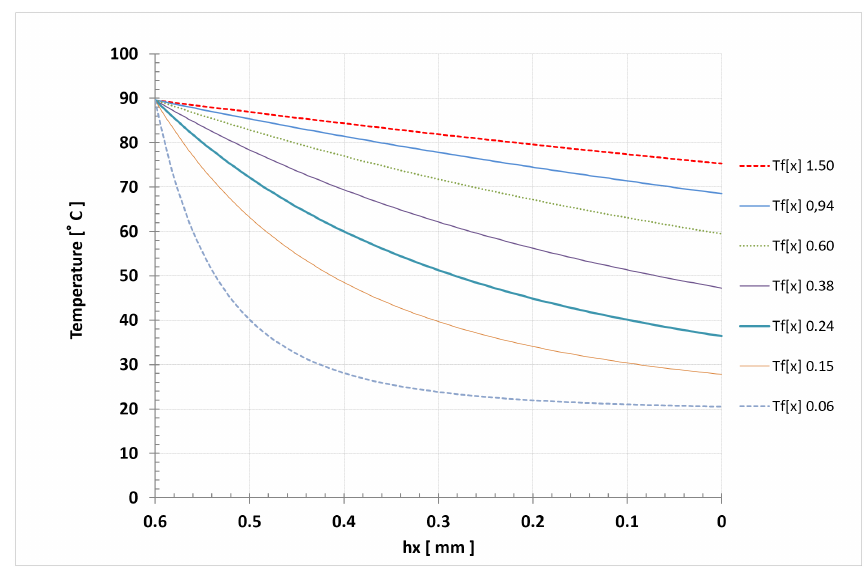
Figure 25. Delonghi -22 water temperature change profile, t s = 90.0 ◦ C, t i = 19.9 ◦ C, q mx from 6.0% to 150%, ( q nom ).